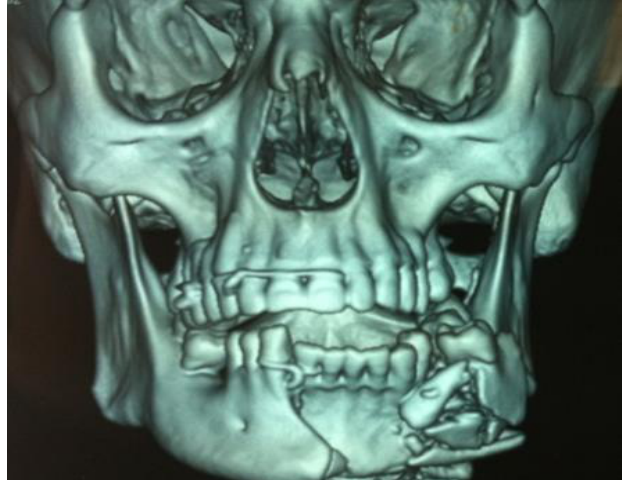
Fig. 1e. 3D-CT shows a combination of symphyseal & right condylar fracture, associated with left maxillary fracture.